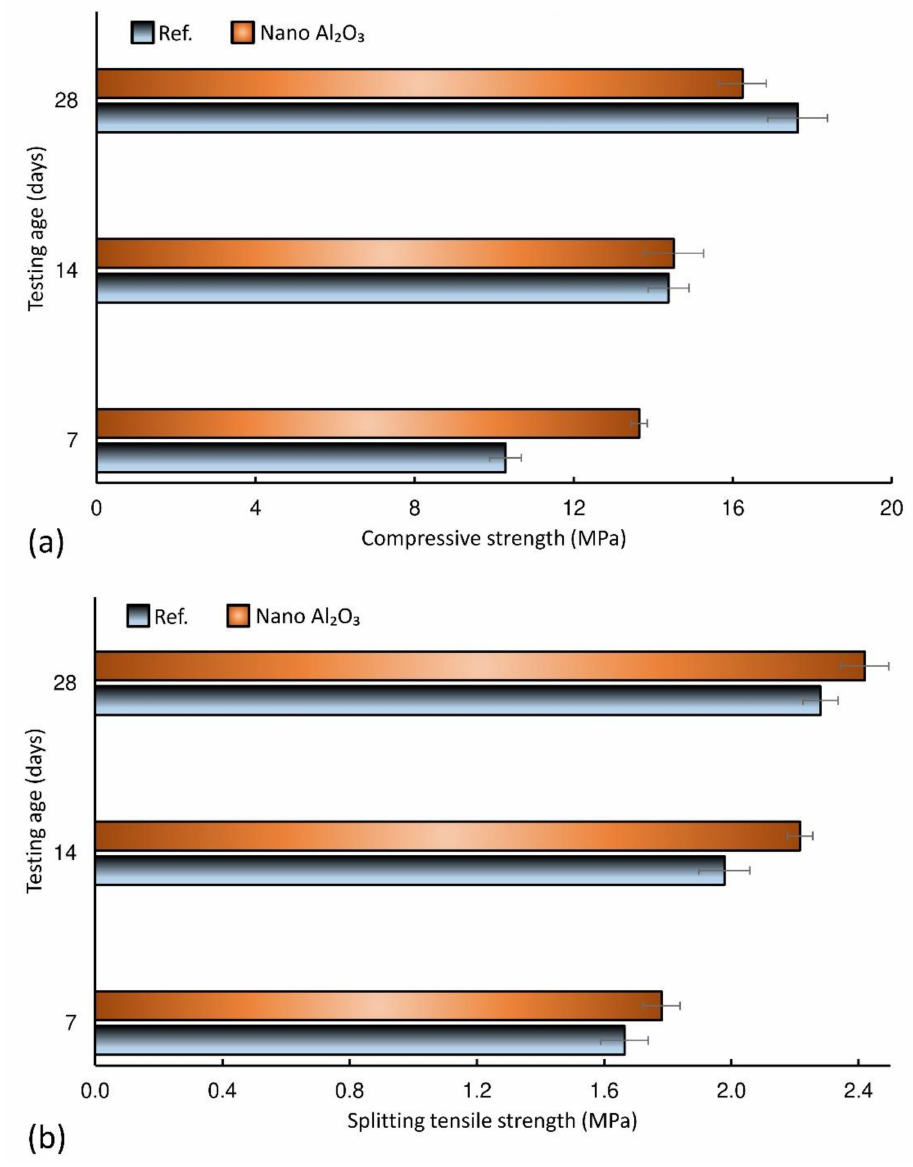
Figure 8. ( a ) Compressive strength and ( b ) splitting tensile strength development in the presence of the optimum concentration of nano-Al 2 O 3 particles